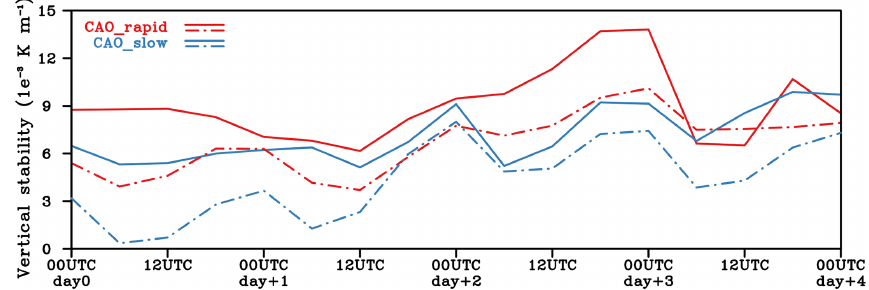
Figure 11. Evolution of spatially averaged (NEC; 114–122 ◦ E, 30–40 ◦ N) vertical stability at the upper boundary of the cold air mass (solid line) and the averaged vertical stability in the cold air mass (dash dot line) during a CAO_rapid event from 14 to 17 December 2016 (red) and a CAO_slow event from 11 to 14 February 2018